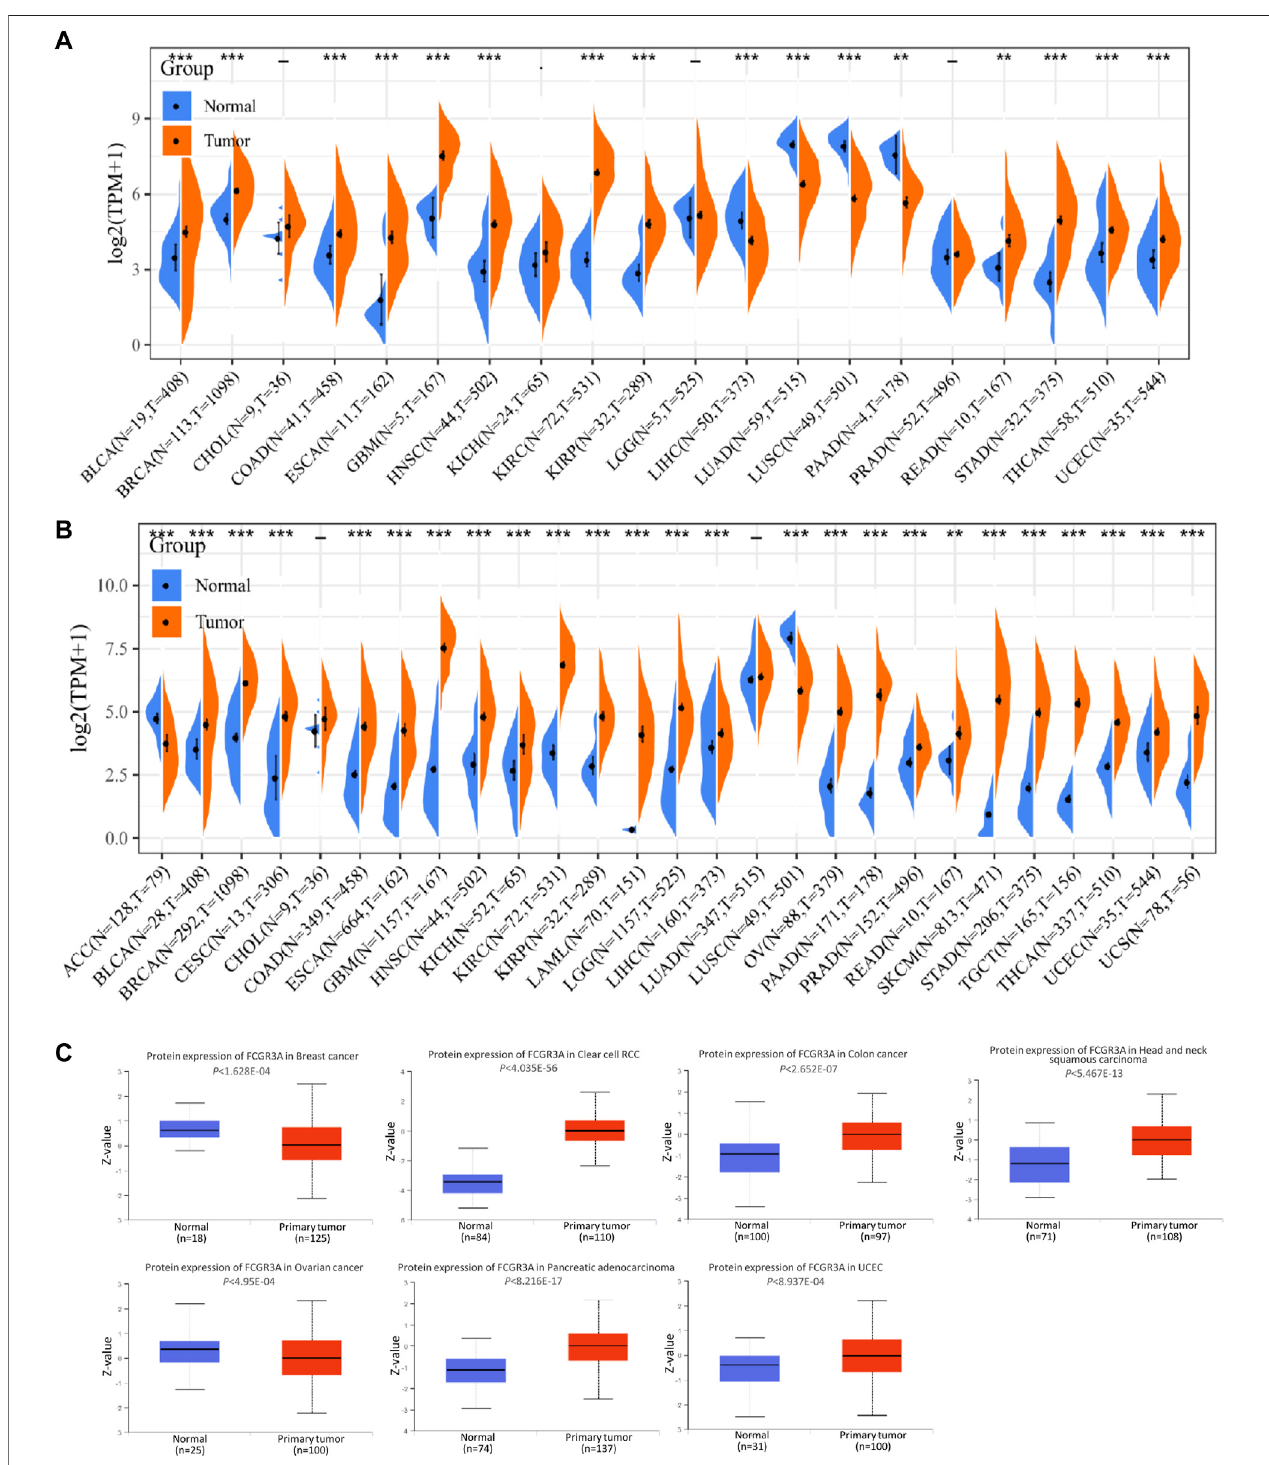
FIGURE 1 | Expression level of FCGR3A gene in pan-cancer. (A) FCGR3A expression levels in tumors containing 20 TCGA tissues and paired adjacent non- canceroustissues; (B) FCGR3Aexpressiondifferencein27tumorsintegratingdataofnormaltissuesinGTExdatabaseanddataoftumortissuesinTCGAdatabase; (C) Based on the CPTAC dataset, the expression level of FCGR3A protein in normal and primary tumor tissues was analyzed. * p < 0.05; ** p < 0.01; *** p < 0.001.